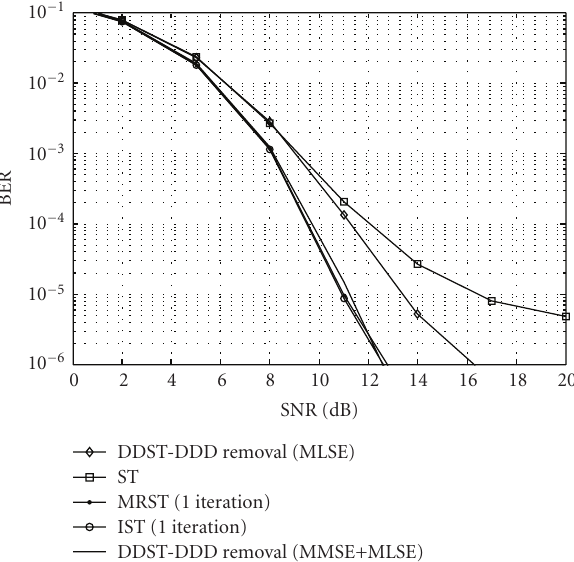
Figure 5: BER performance of BPSK signals with MLSE equalizer.